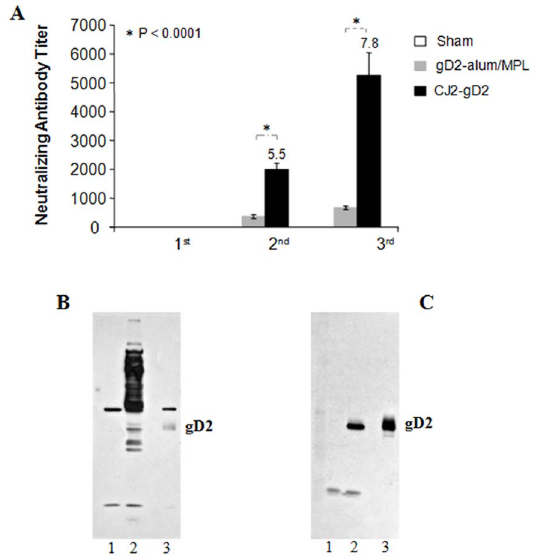
Figure 2. CJ2-gD2 is significantly more effective than gD2- alum/MPL subunit vaccine in eliciting an HSV-2-specific neutralizing antibody response in immunized guinea pigs. A. Female Hartley guinea pigs were randomly assigned to three groups of eight animals each in the first experiment and three groups of six to eight each in the second experiment. They were either sham- immunized with DMEM (n=8, 8), immunized with 3 m g of purified recombinant gD2 freshly formulated with 7.5 m g of MPL and 75 m g of alum (n=8, 6) or immunized with CJ2-gD2 (n=8, 6) at a dose of 5 6 10 6 PFU on days 0, 14, and 28. Blood was taken after the first, second, and third immunizations as detailed in the Materials and Methods. Heat inactivated serum from each animal was assayed individually for HSV-2-specific neutralizing antibody titers on Vero cell monolayers. The results represent average titers 6 SEM. B and C. Western blot analysis with serum prepared from CJ2-gD2 (B)- and gD2- alum/MPL (C)-immunized guinea pigs as detailed in the Materials and Methods. Lanes 1, 2, and 3 represent cell extracts prepared from mock- infected Vero cells, HSV-2-infected Vero cells, and gD2-transfected U2OS cells, respectively.